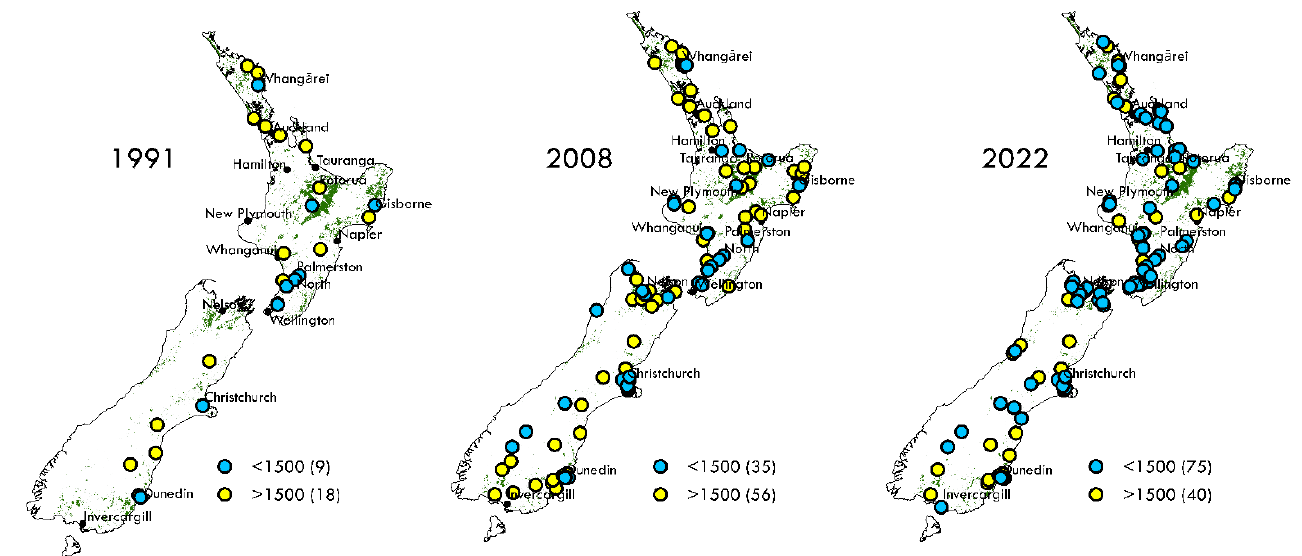
Figure 3. Permitted access for mountain bike users to New Zealand production plantation forests in 1991, 2008, and 2022. Forest counts in parenthesis. Yellow points = forests > 1500 ha; cyan points = forest < 1500 ha (including mountain bike parks); green shading = production plantation